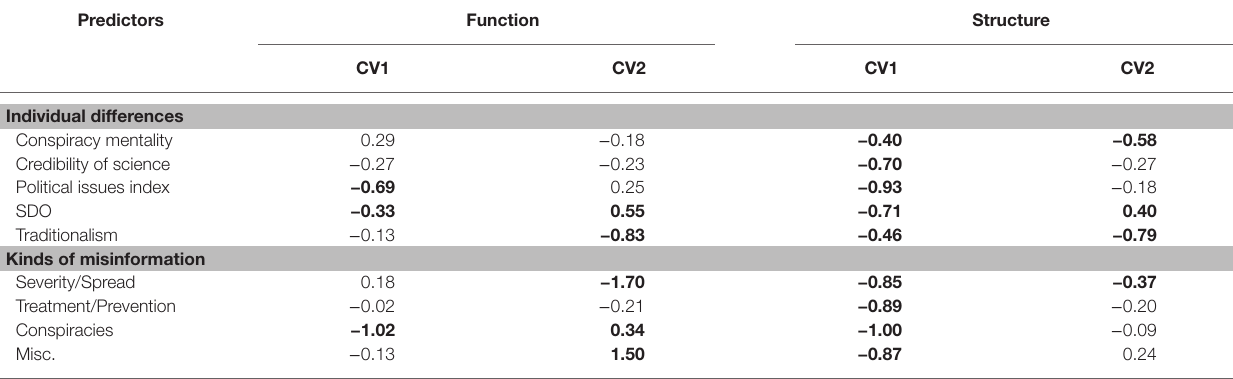
TABLE 4 | Standardized function and structure coefficients for the first and second canonical variates. Predictors Function